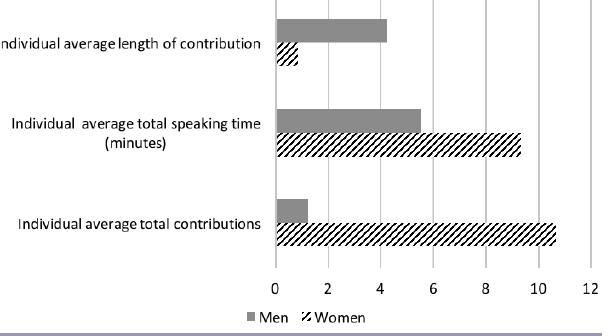
Fig. 10 . Gendered styles of participation from meetings 3 and 4, men’s and women’s dispute resolution meetings.